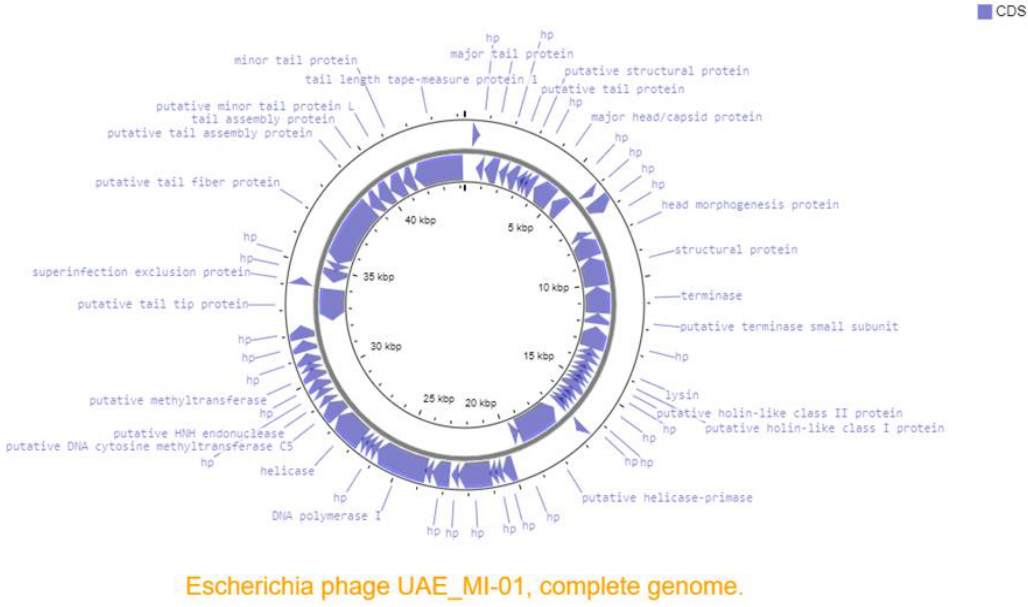
Figure 4. Genome map of the phage UAE_MI-01 drawn using Proksee. Blue arrows shows ORFs with predicted annotations. hp indicates hypothetical protein.